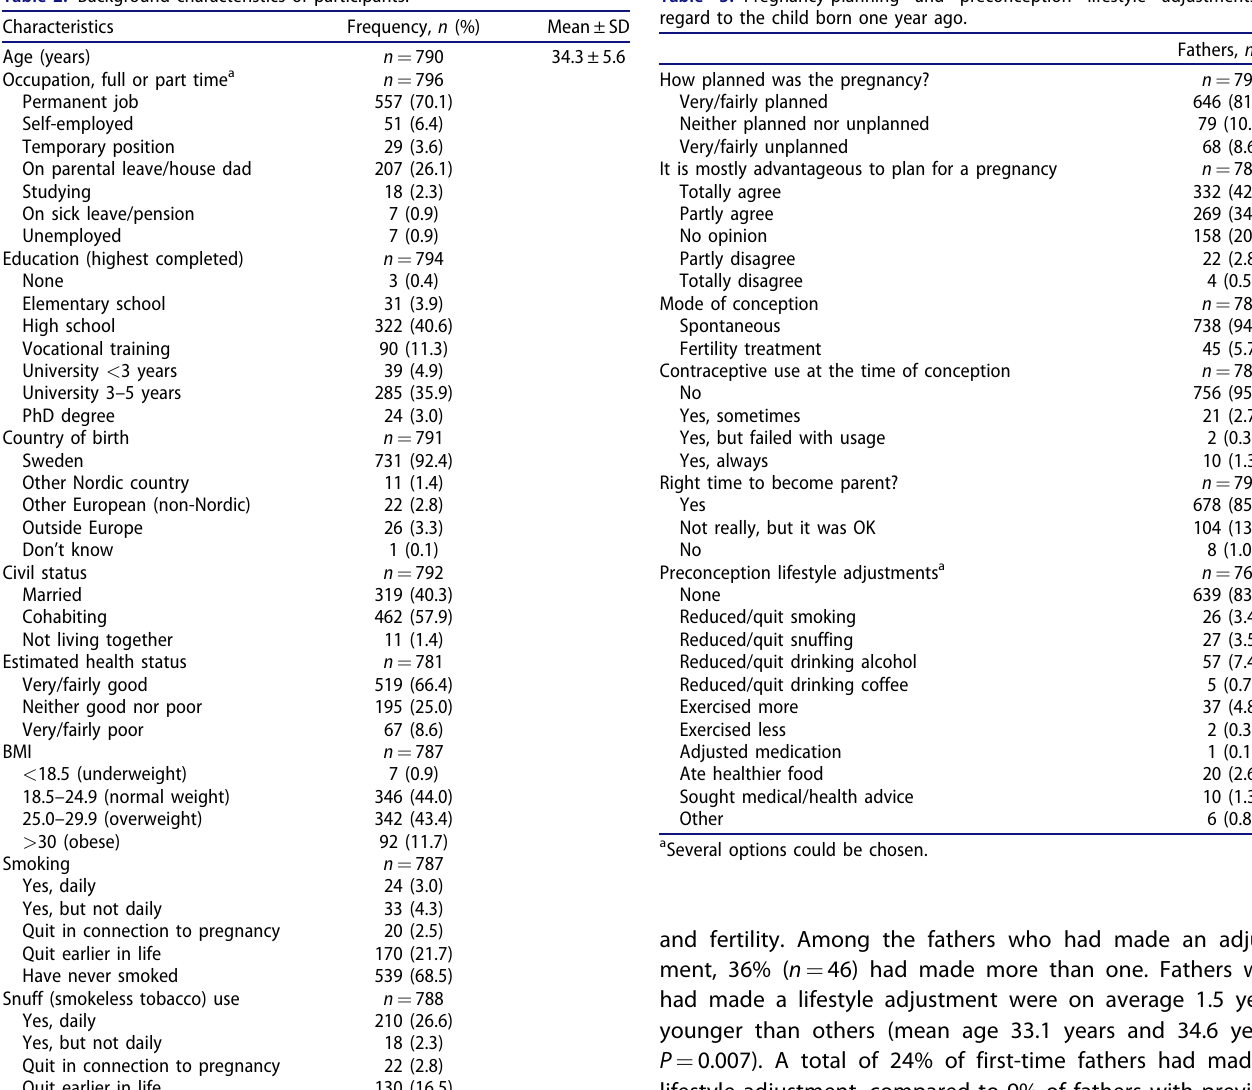
Table 2. Background characteristics of participants. Characteristics